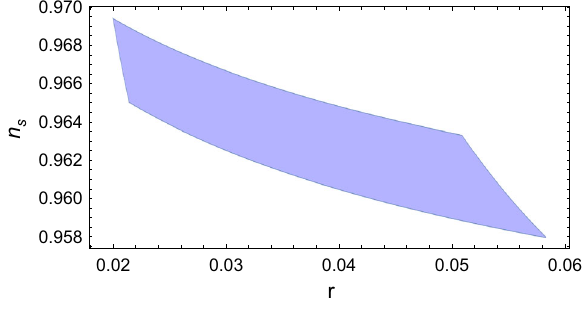
≤ 0 . 07 and 0 . 27 (cid:2) a 0